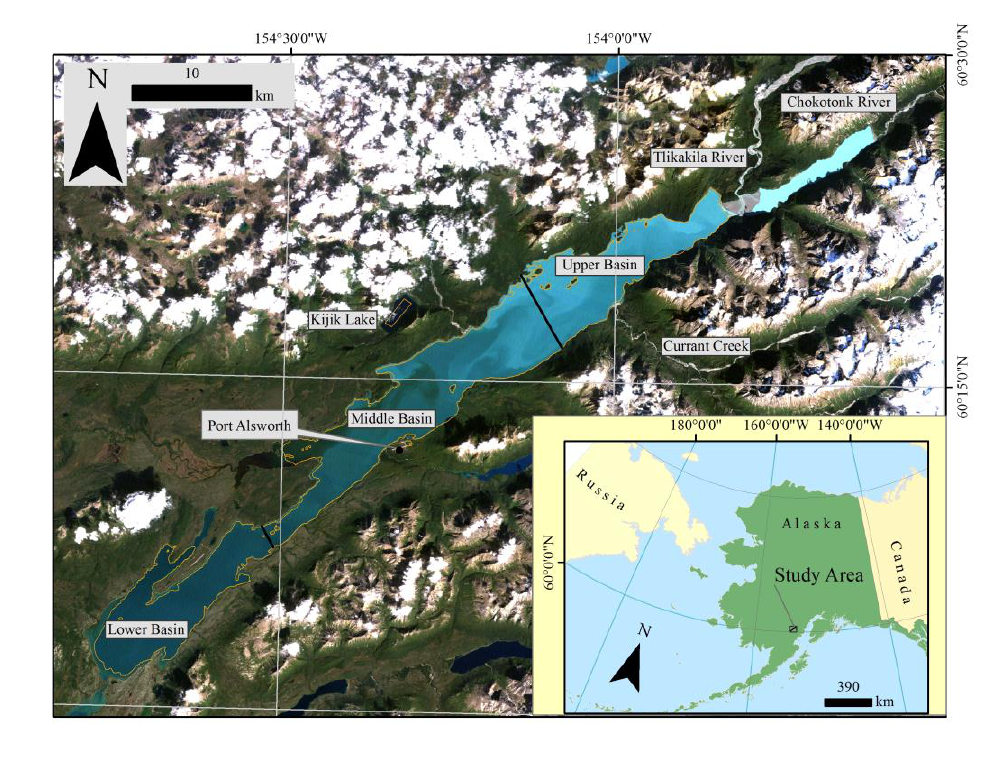
Figure 1. Regional setting of Lake Clark. The background is a Landsat 5 scene taken 3 September 1995 that shows the turbidity gradient within Lake Clark. Black lines denote division of Lake Clark into upper, middle and lower